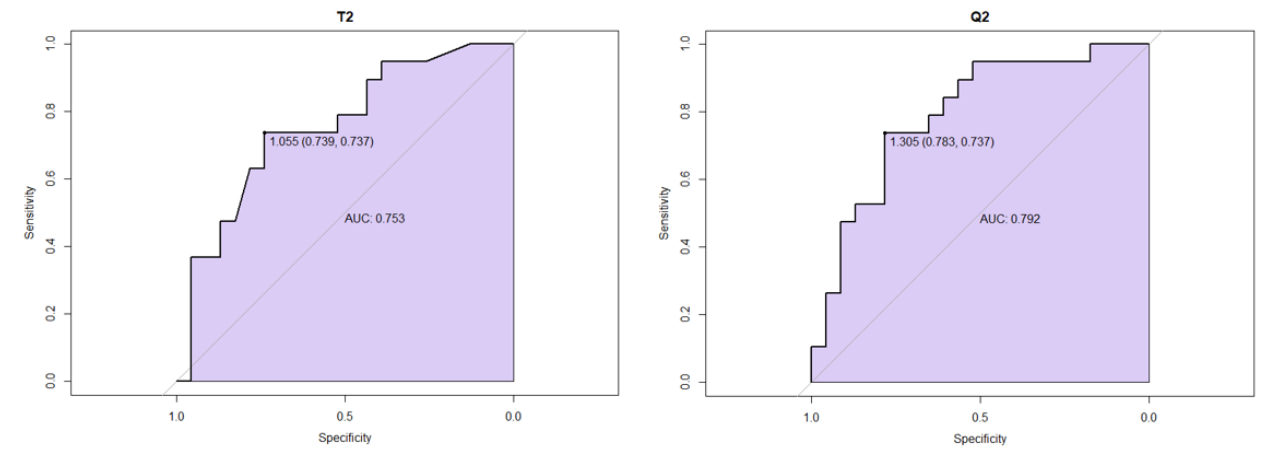
Figure 4. ROC curves for the peritumoral white matter regions (T2) and normalized values of the peritumoral white matter regions